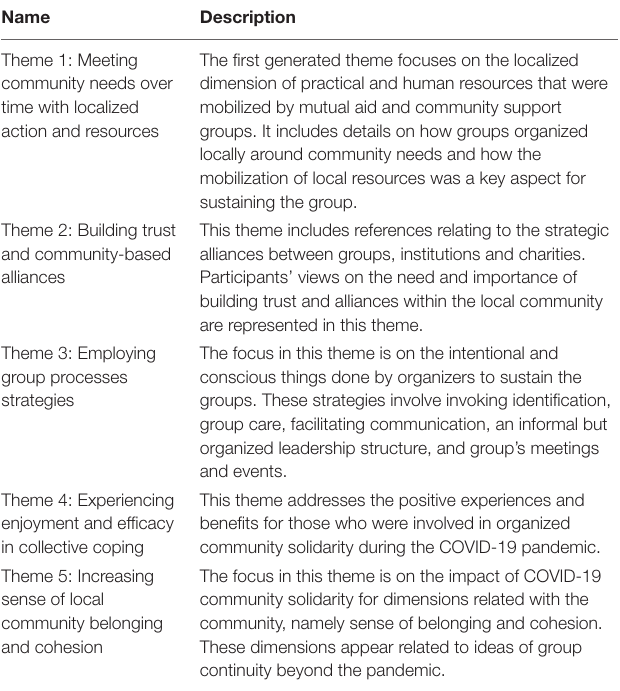
TABLE 2 | Overview of the generated